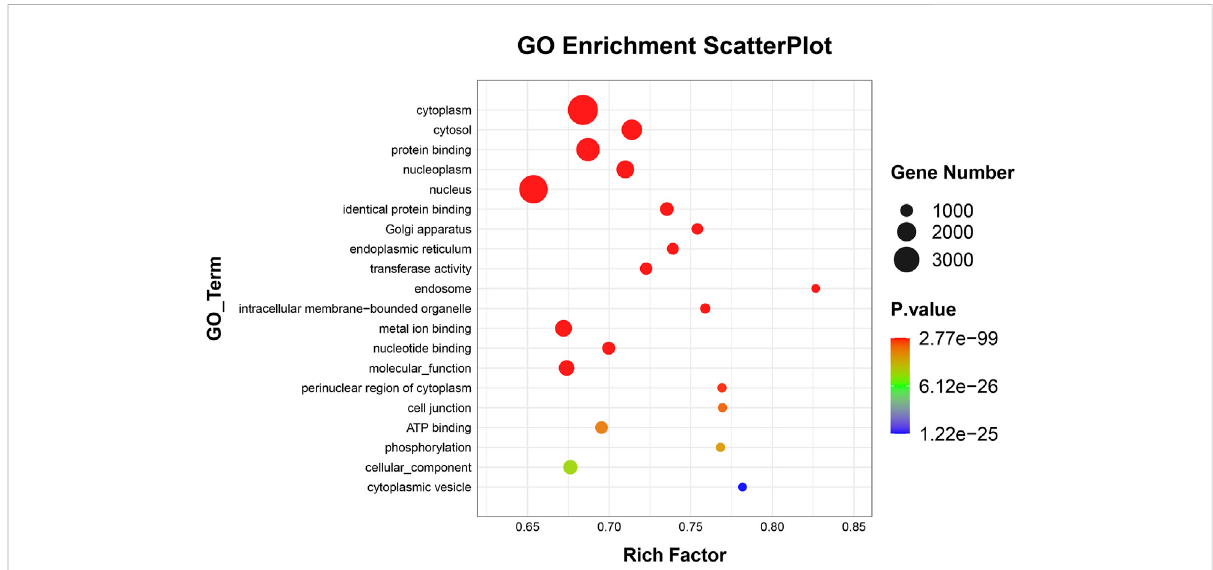
FIGURE 9 GO enrichment of genes encoding miRNAs expressed differentially between the Force-Exo and Control-Exo groups. Bubble size represents the number of differential genes annotated for a GO term. The redder the color, the smaller the signi fi cance and higher the enrichment level.